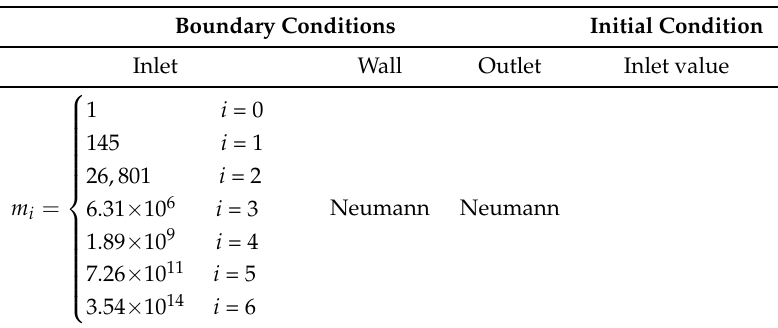
Table 15. Boundary and initial condition for m i equations used in Test Case